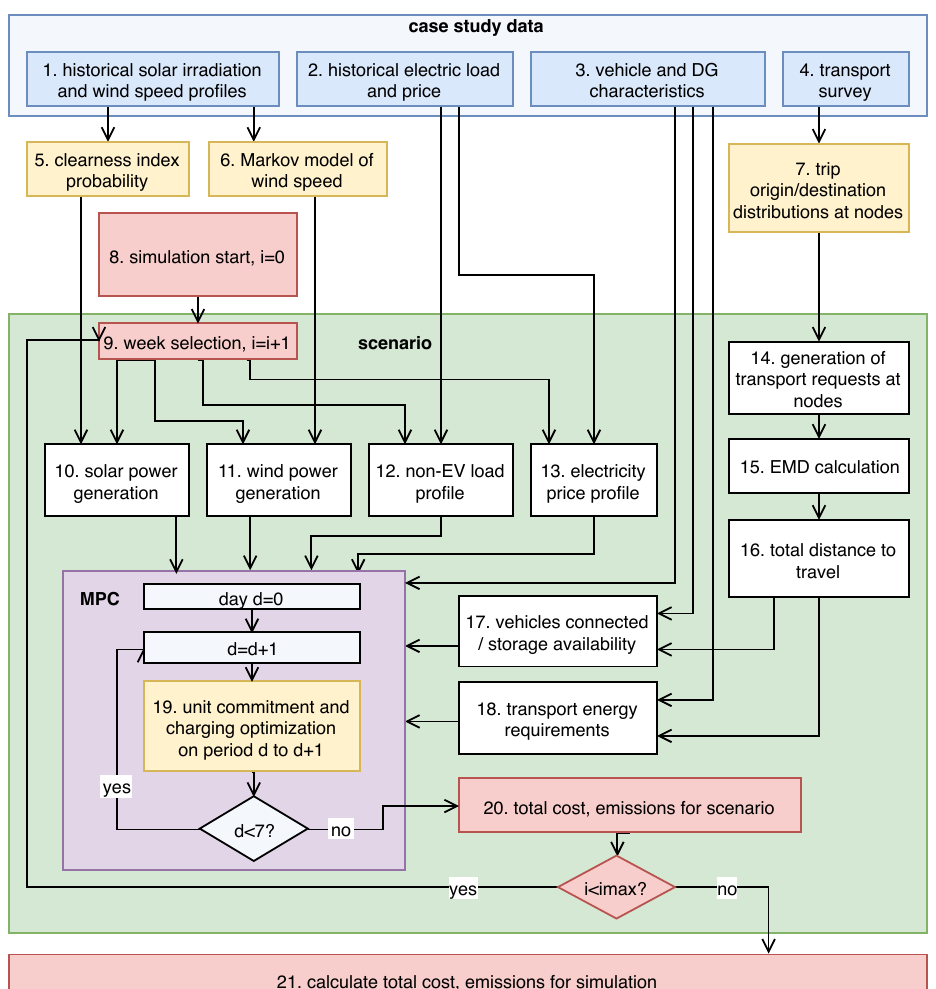
Figure 1. Model flow